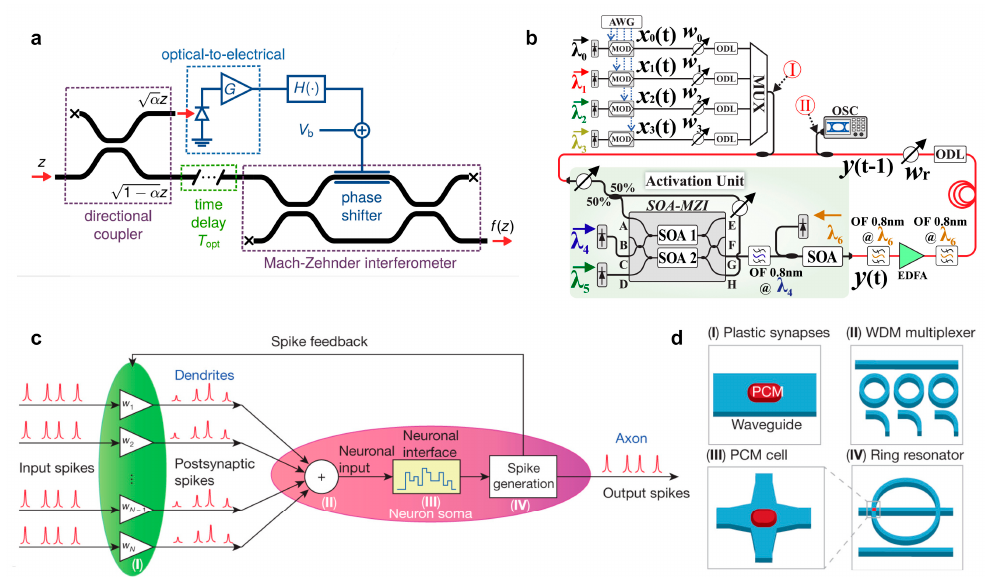
Figure 2. Activation function in ONNs. ( a ) Schematic of the proposed optical-to-optical activation function [19]. ( b ) Experimental setup used for the evaluation of the 4-input WDM RNN (Recurrent neural network) [21]. ( c , d ) Schematic of the network realized in this study, consisting of several pre-synaptic input neurons and one post-synaptic output neuron connected via PCM synapses [18]. ( a ) Reprinted with permission from Ref [19]. Copyright © 2020, IEEE. ( b ) Reprinted with permission from Ref [21]. Copyright © 2020, IEEE. ( c , d ) Reprinted with permission from Ref [18], Springer Nature Limited.